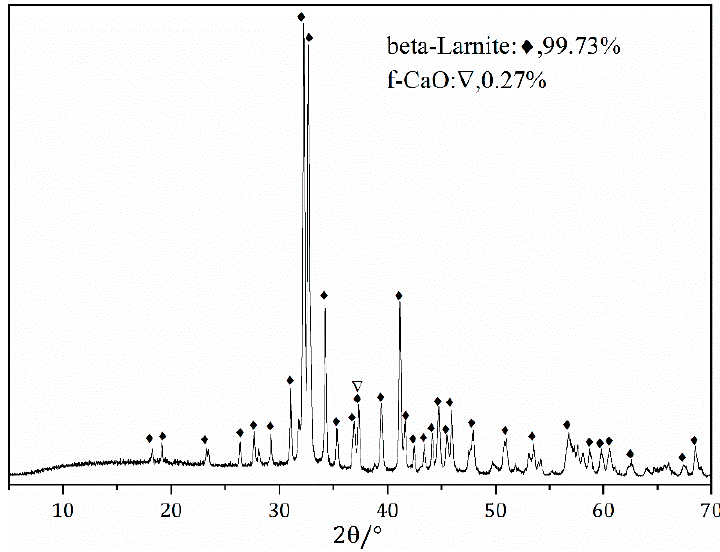
Figure 3. XRD pattern for the synthetic β － C 2 S as a raw material for the preparation of ternesite.